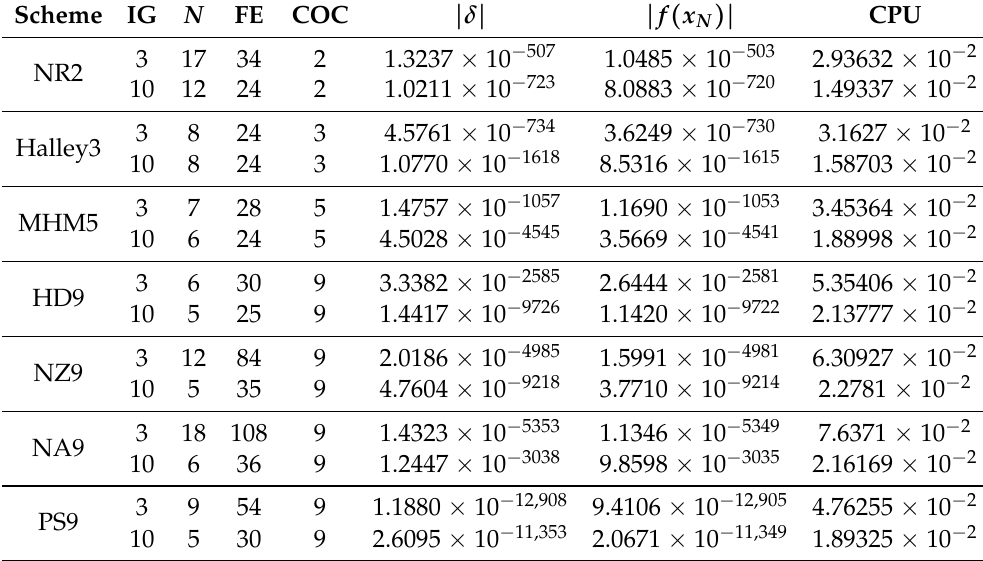
Table 5. Numerical results for problem 2 ( f 3 ( x )) with two different initial